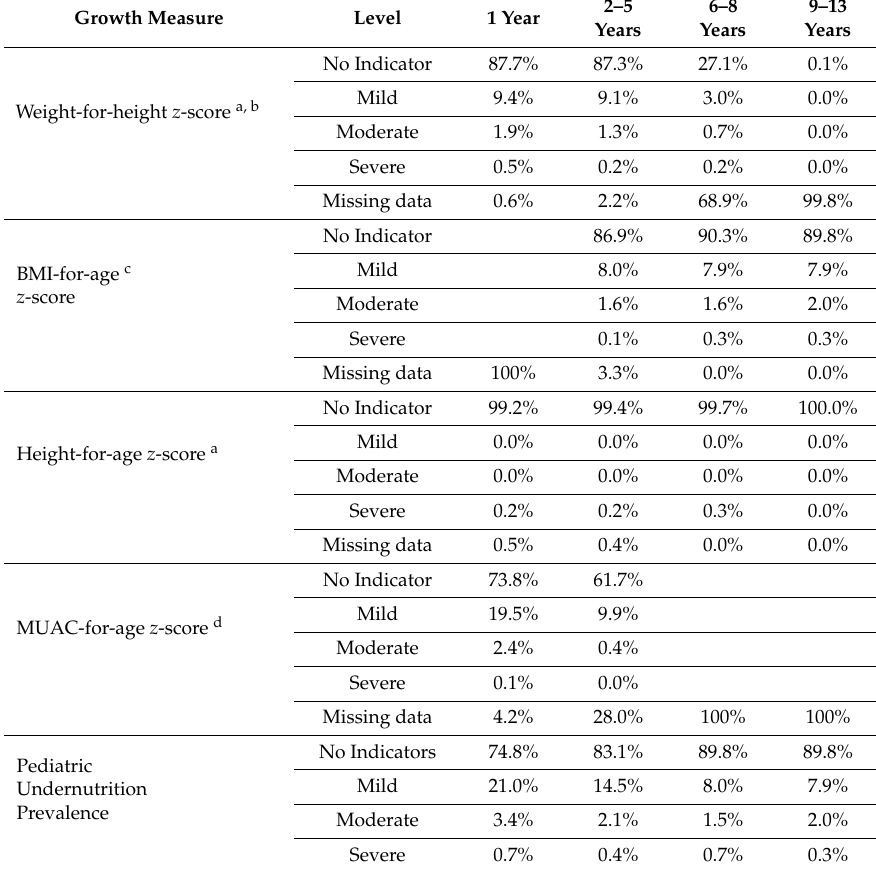
Table 3. Nationally-representative proportion of US children presenting with undernutrition criteria identified by growth z -scores across age groups and undernutrition prevalence according to age groups from National Health and Nutrition Examination Survey (NHANES) 2005–2014 data ( n =